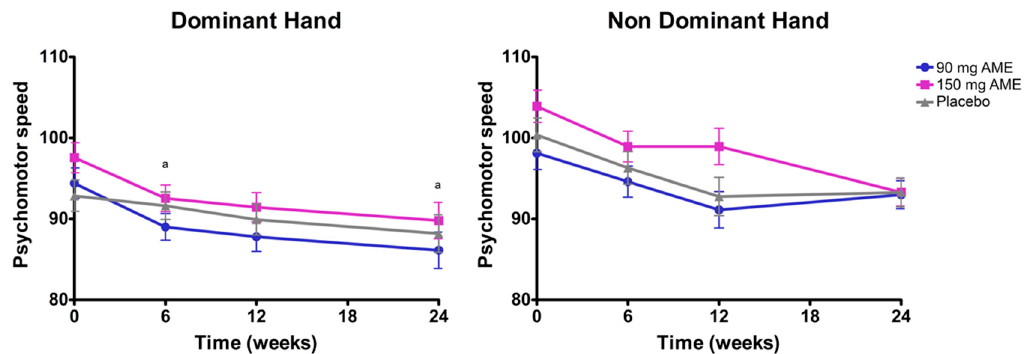
Figure 1. The effect of Aronia melanocarpa extract (AME) supplementation on psychomotor speed of the dominant and non-dominant hand. Data are presented as actual mean ± SEM. Analysis was performed with a linear mixed model using estimated means, with correction for baseline values. Post hoc analyses were performed for the factor time*treatment, treatment, or time, where applicable. Statistically significant differences between two timepoints are denoted by the letter a. Lower scores indicate better performance.